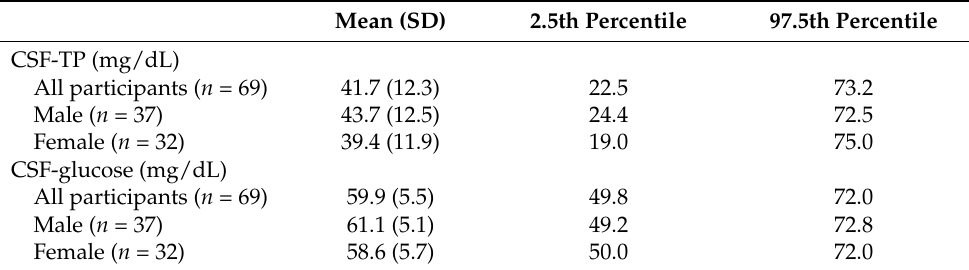
Table 1. Mean, 2.5th and 97.5th percentiles of CSF-TP and CSF-glucose.